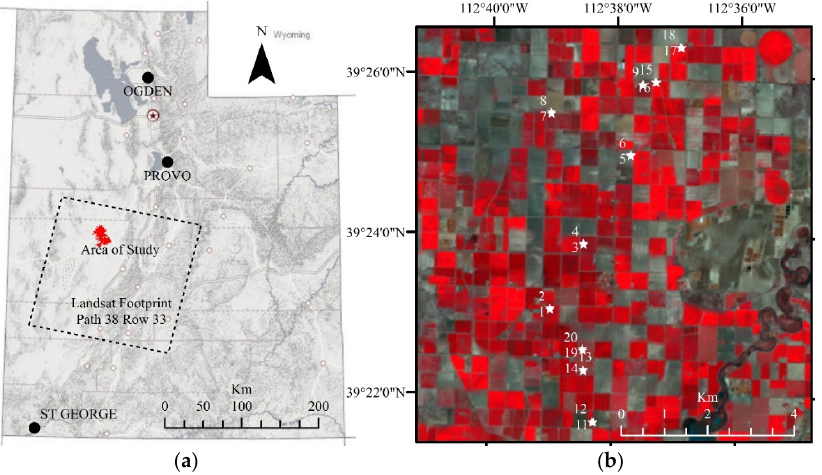
Figure 1. ( a ): Landsat Path 38 Row 33 scene footprint (dashed lines) and area of study (black). ( b ): gap-filled Landsat 7 ETM+ false view (29 May 2012) of the area of study and soil moisture sampling sites (stars) in Central Utah.